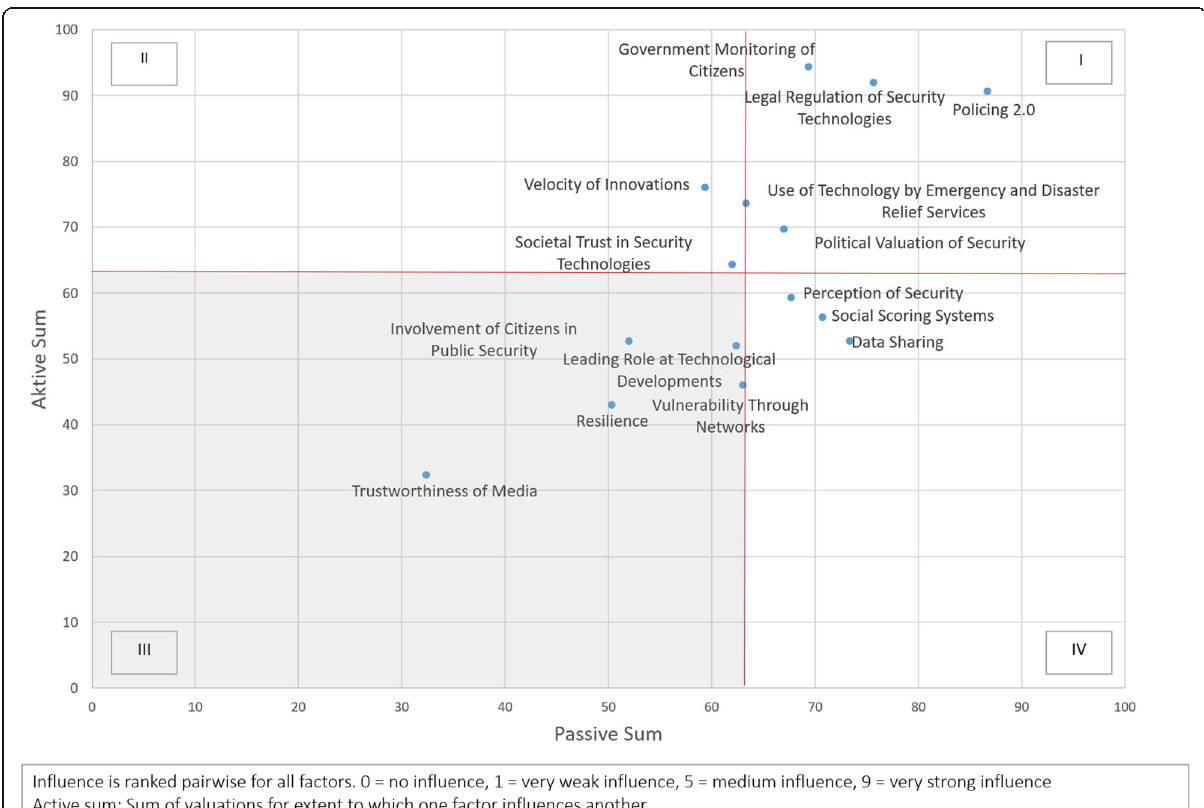
Fig. 3 Example projections for key factor “ Policing 2.0